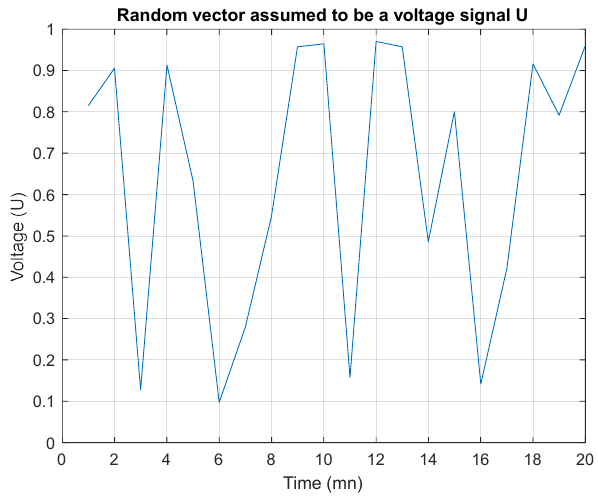
Figure 3. Gaussian random signal (U).